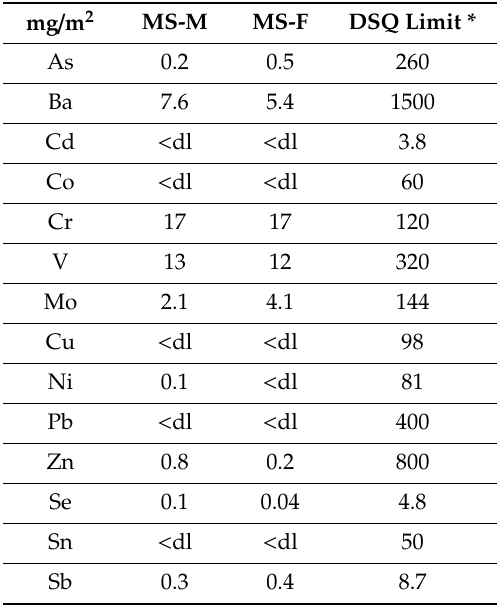
Table 4. Concentrations of potentially hazardous elements in the NEN 7345 leachates of the MS-M and MS-F acoustic materials compared with the DSQ limit [27]. mg / m